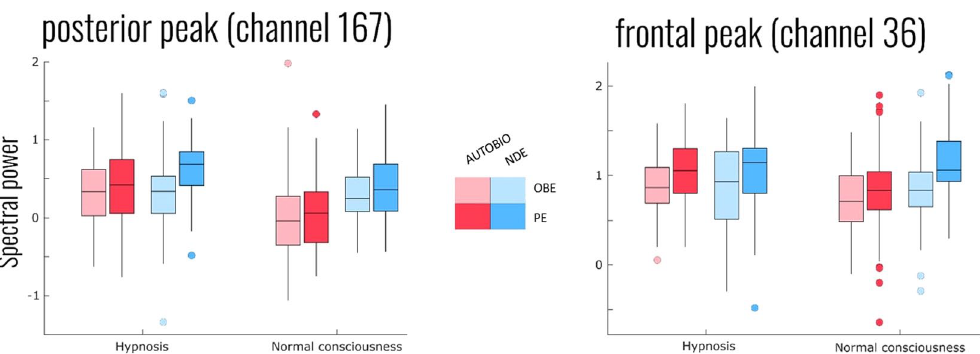
Figure 3. Spectral power of alpha activity for two selected channels with peak significant differences between near-death experience (NDE) and recollection of another autobiographical event (AUTOBIO) (highlighted in the bottom right of Fig. 3). The left graph shows the right-of-midline posterior channel also split by hypnosis (HY) and normal consciousness (NC) as well as recall of out-of-body experience (OBE)/kinaesthetic sensation (KS) (light coloured) or peacefulness (PE) (darker coloured). Here, the highest spectral power in NDE versus AUTOBIO is reflected in the NC condition, and only in the PE condition under hypnosis. The right graph shows the slightly left-of-centre frontal peak channel. At the frontal channel, the NDE condition has slightly higher spectral power during HY, but only for the PE condition during